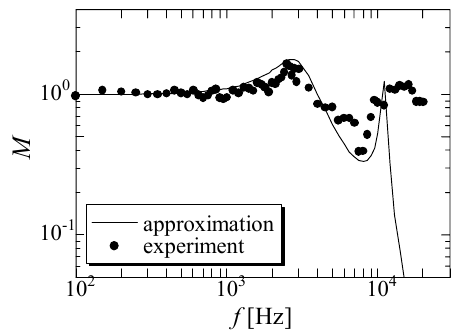
Fig. 4 Ratio of magnitude M vs. frequency f .